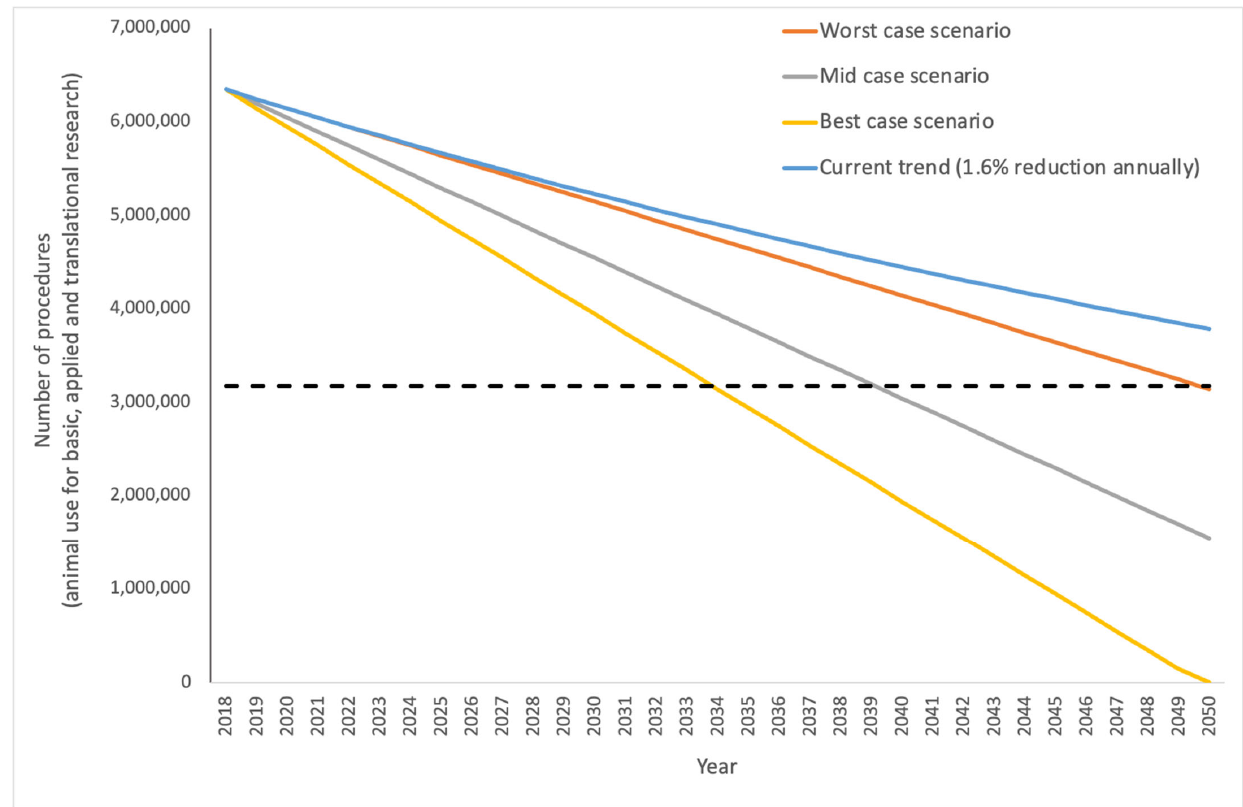
Figure 3. Projection of different reduction targets for animals used in biomedical research, based on a linear decrease. Beginning with the most recent data [7] where over 6.3 million animals were used for biomedical research across 28 Member States (without Norway), the blue line indicates the trajectory if animal use was reduced by 1.6% per year in accordance with current trends. For reference, the dashed line indicates the position of 50% of current, 2018 use (i.e., 317,899 animals). If an annual 1.6% decrease was maintained, the use of animals would not even be halved by 2050. We present three alternative scenarios: the orange line shows a ’worst case’ ‐ reduction of 100,000 animals per year; the grey line represents the ‘mid case’—reduction of 150,000 animals per year; and the yellow line shows the ‘best case’, adopting an annual reduction of 200,000 uses and here, animal use would reach zero by 2050.